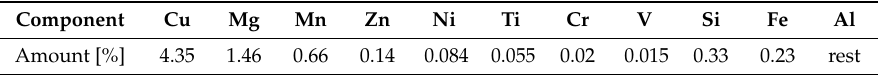
Table 1. Chemical composition of EN AW-2024 alloy (wt.